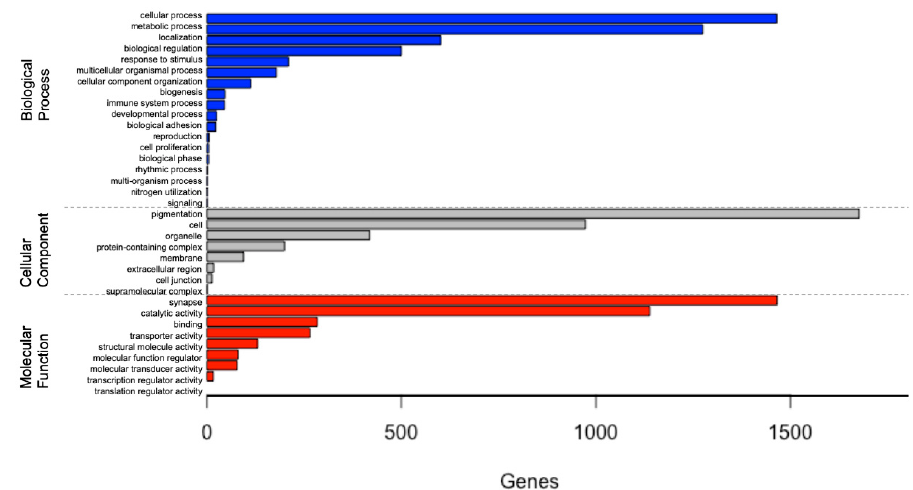
Figure 1. Gene Ontology (GO) analysis of the Latrodectus hesperus ovarian transcriptome according to the identified transcripts involvement in biological process, cellular component, and molecular function categories.